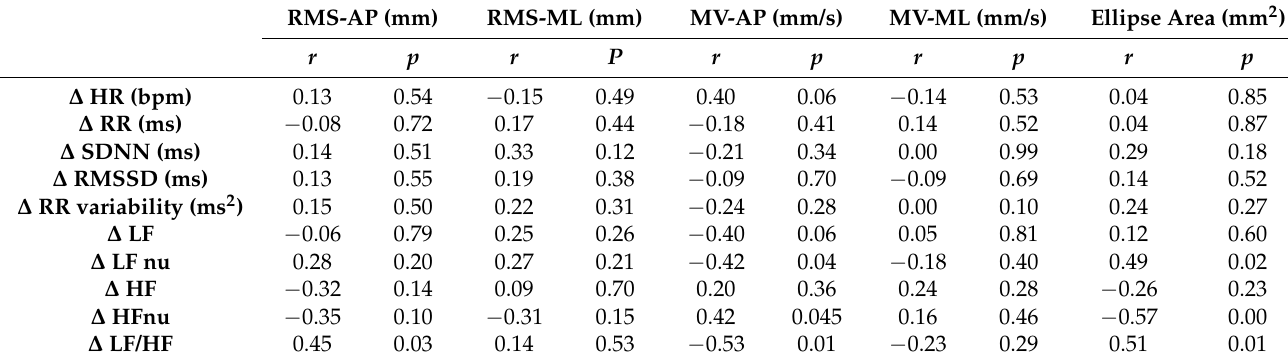
∆ : delta calculated as difference between values obtained at standing and values obtained at supine. HR: heart rate. RR: RR intervals. SDNN: standard deviation of normal-to-normal intervals. RMSSD: Root mean square of successive differences in RR intervals. LF: low frequency. HF: high frequency. RMS: root mean square. MV: mean velocity. AP: anterior-posterior. ML: